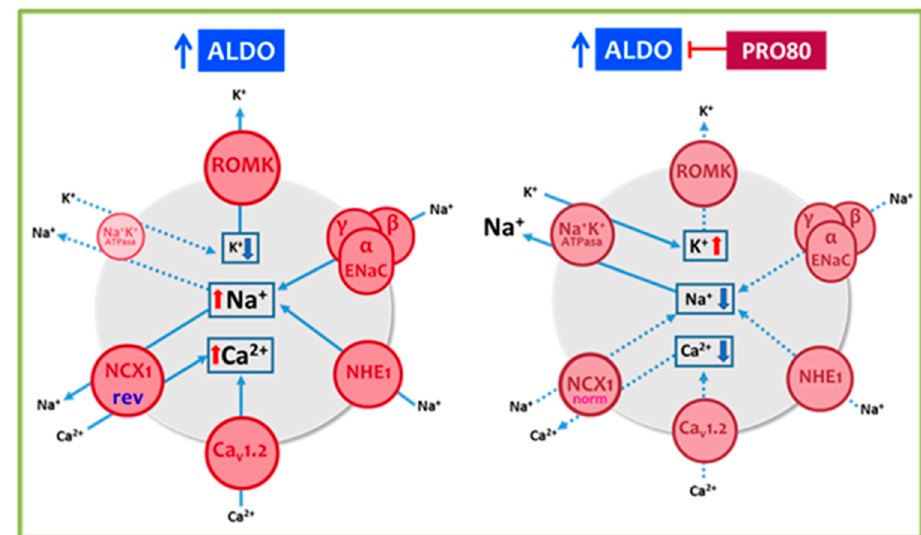
Figure 6. Scheme of the proposed actions of aldosterone and proanthocyanidins in cardiac sodium, potassium and calcium homeostasis by modifying protein expression of the ion channels. Sodium–hydrogen exchanger type 1; NHE1, Na + /K + ATPase pump; NKA, sodium-calcium exchanger type 1; NCX1, renal outer medullary potassium channel; ROMK, L-type volt-age-dependent calcium channel; Cav1.2, calcium/calmodulin-dependent protein kinase II; CaMKII and epithelial sodium channel (ENaC). Full lines represent increased ion transient and dotted lines represent decreased ion transient trough the transporters.